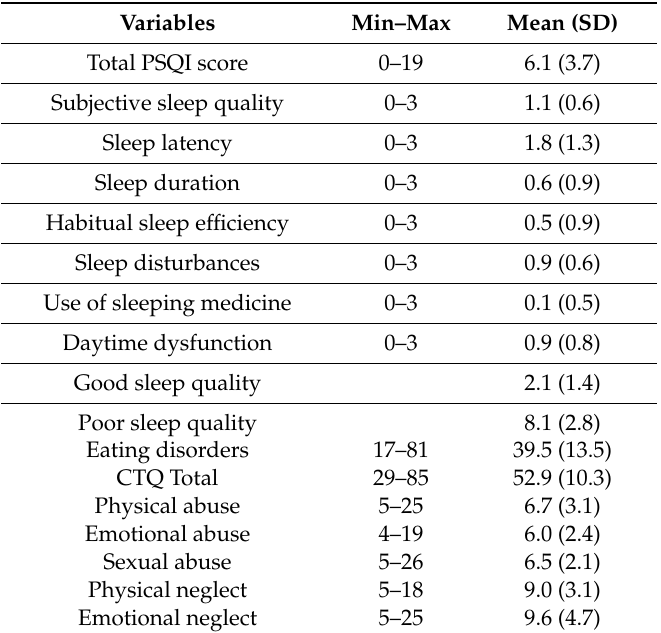
Table 2. Sleep Quality, Eating Disorders, and Childhood Trauma Levels ( n = 279).